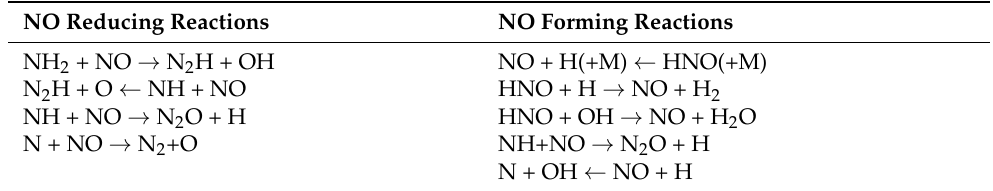
Table 1. NO forming and reducing reactions